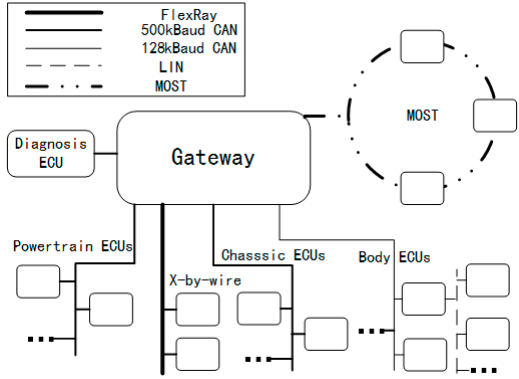
Figure 1. CAN bus serving as a backbone in most current vehicles.